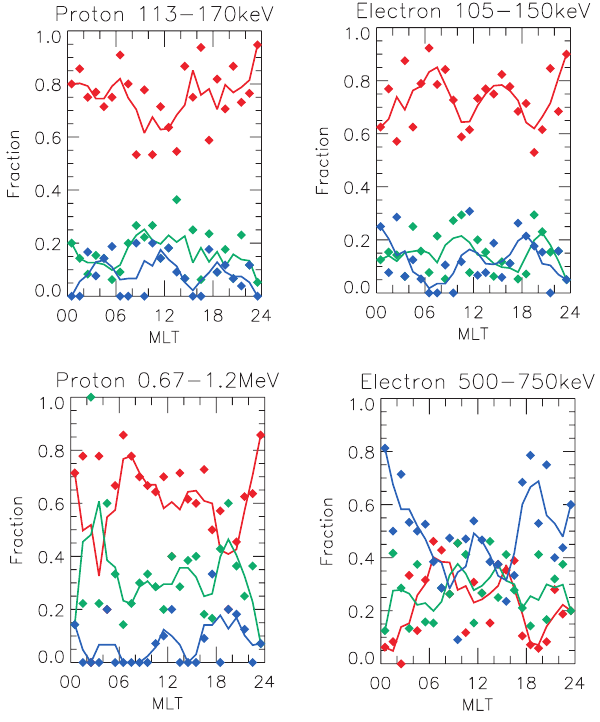
Fig. 5. The same as Fig. 4, except that it is for storm times and that it plots the averaged percentage of each flux variation category instead of the fitting